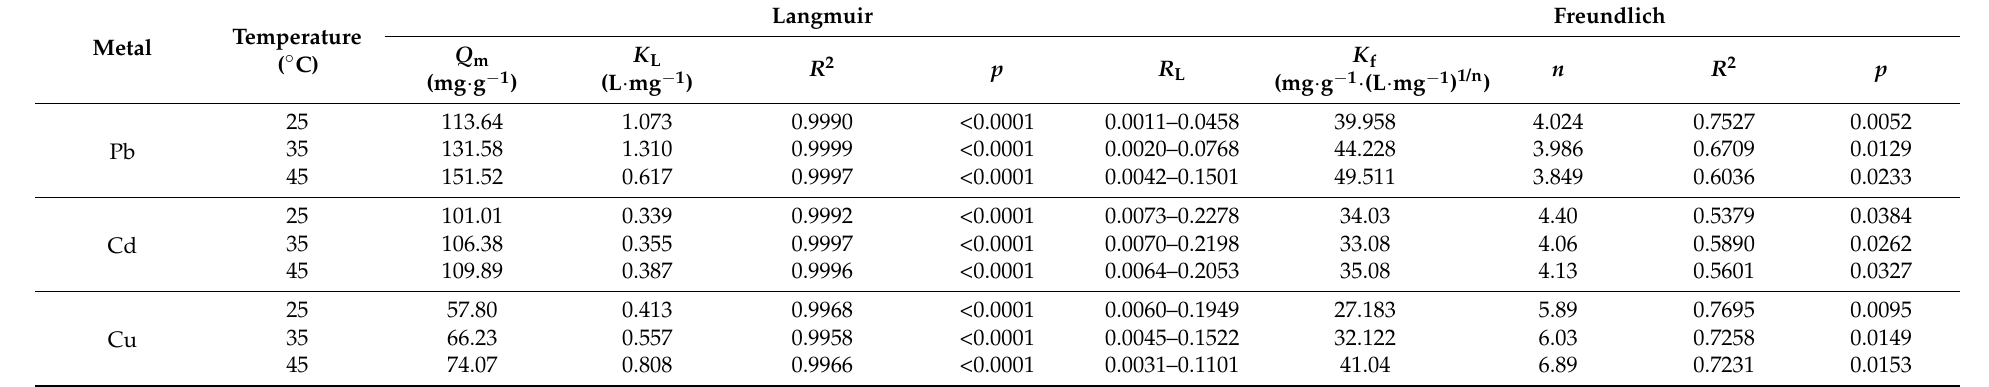
Table 3. Adsorption isotherm parameters of heavy metals onto MSBC-2 at different temperatures for Langmuir and Freundlich